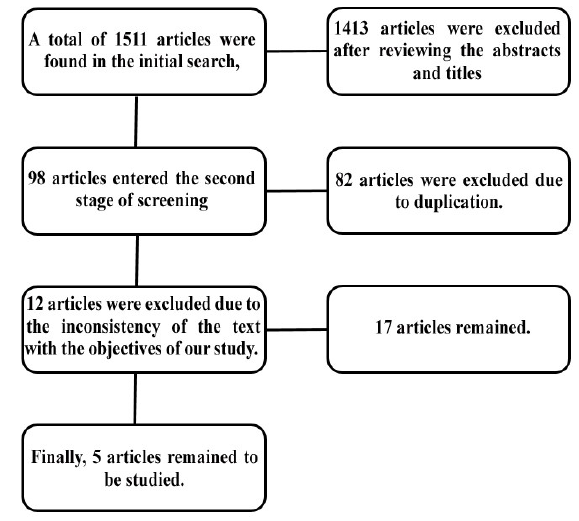
Figure 1. Steps for including articles in the systematic review and meta-